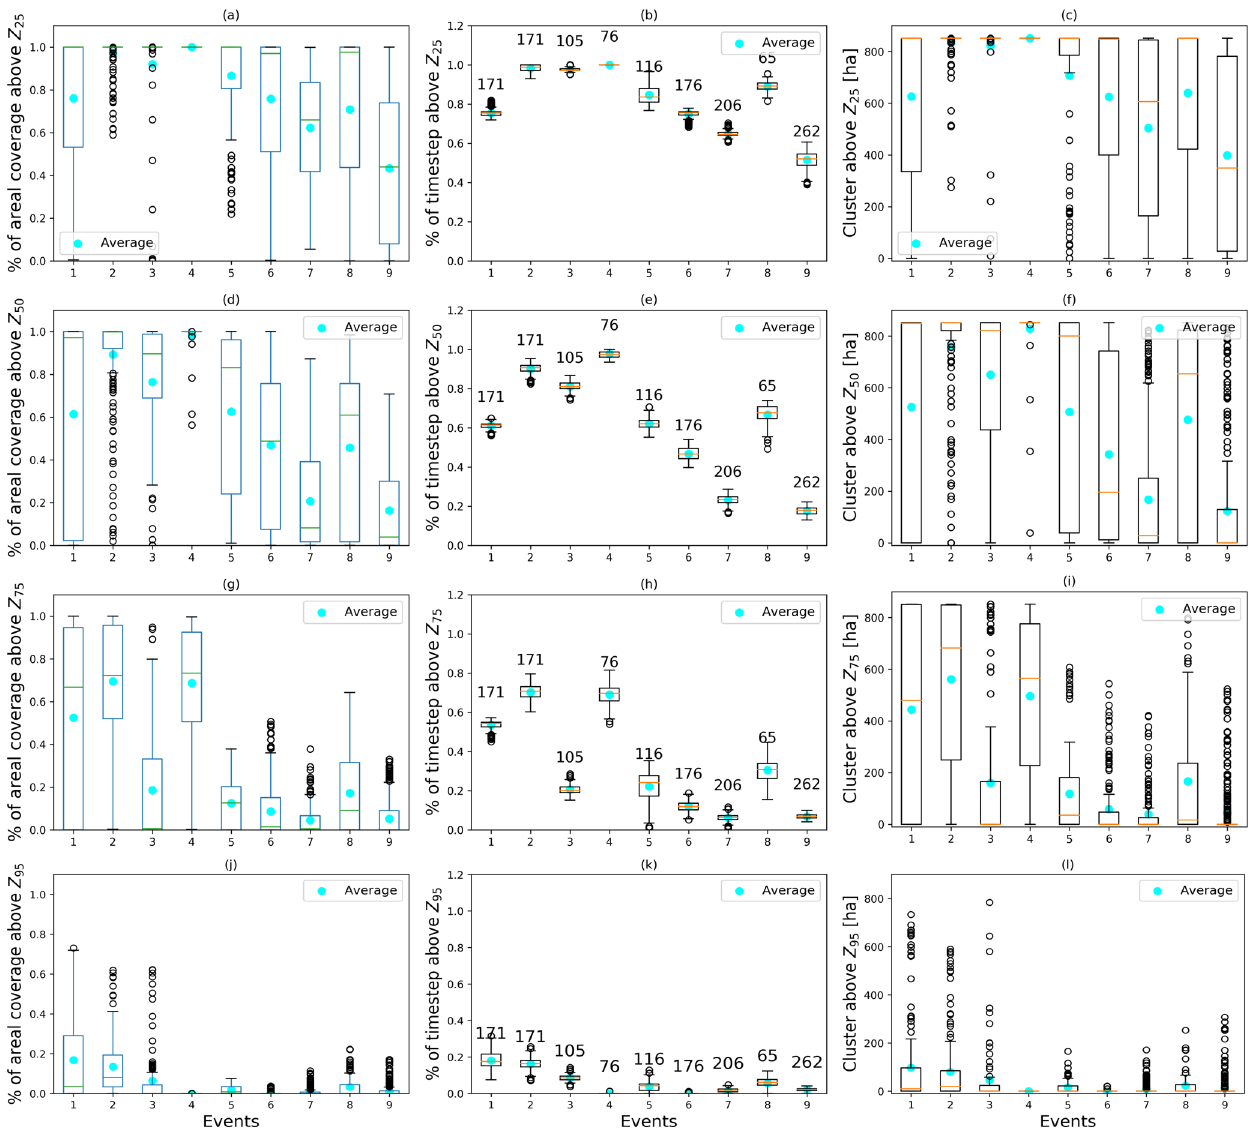
Figure 3. Percentage of areal coverage above selected threshold, calculated over all time steps and per rainfall event (a, d, g, j) . Temporal percentage of coverage above the selected threshold, defined as number of time steps above the threshold at each pixel, divided by the total duration of the event (b, e, h, k) . Temporal percentage is presented for each rainfall event and the number above each box plot indicates the total duration of the rainfall event. Cluster dimensions across all time steps per event for the four selected thresholds (c, f, i, l) . Blue dots represent the average, green or red lines the median, boxes indicate the first to third quartile, and whiskers extend 1.5 times the interquartile range below the first and above the third